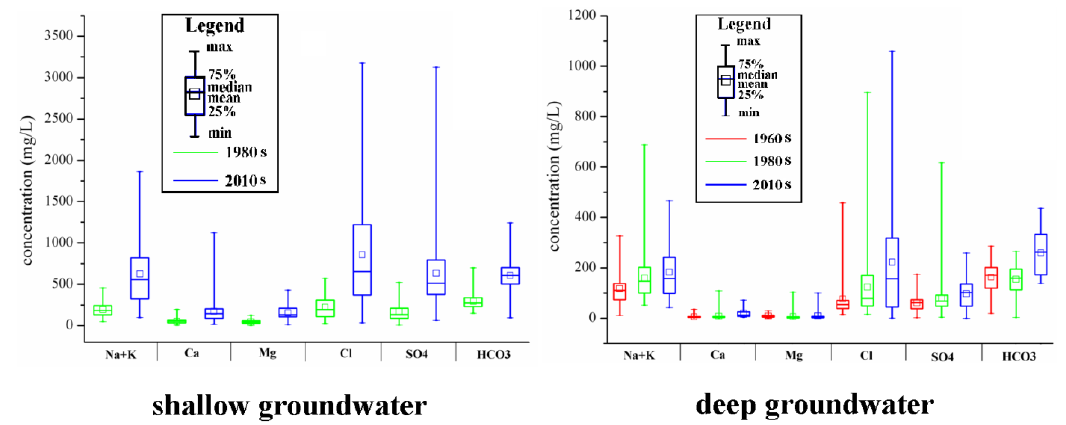
Figure 5. Concentration distribution of major ions across